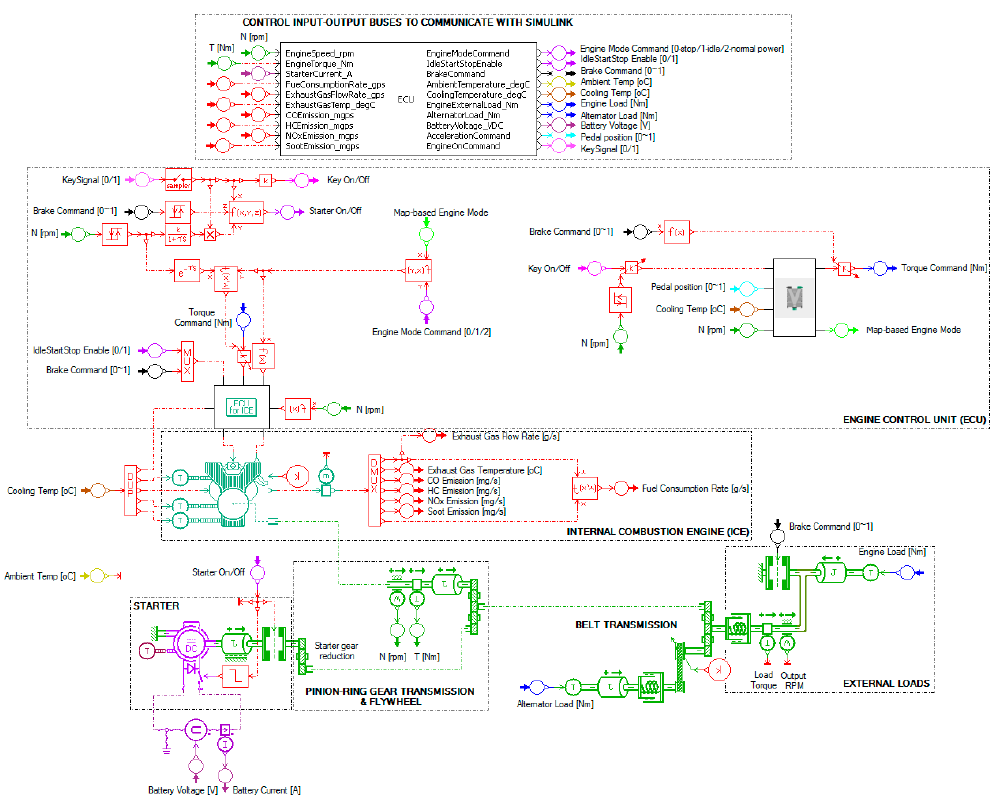
Figure 2. Components’ model set built in AMESim.